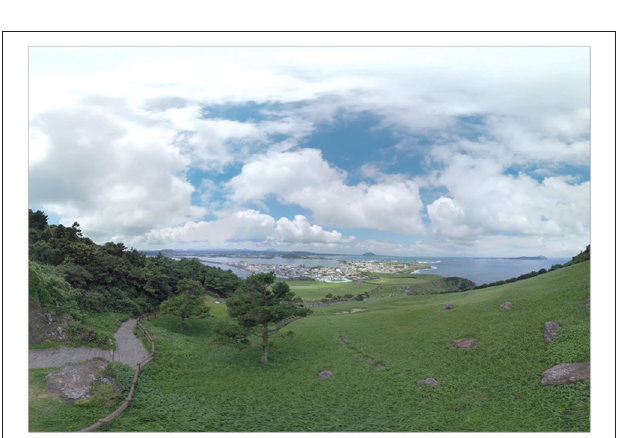
FIGURE 4 | Immersive VR video. VR, virtual